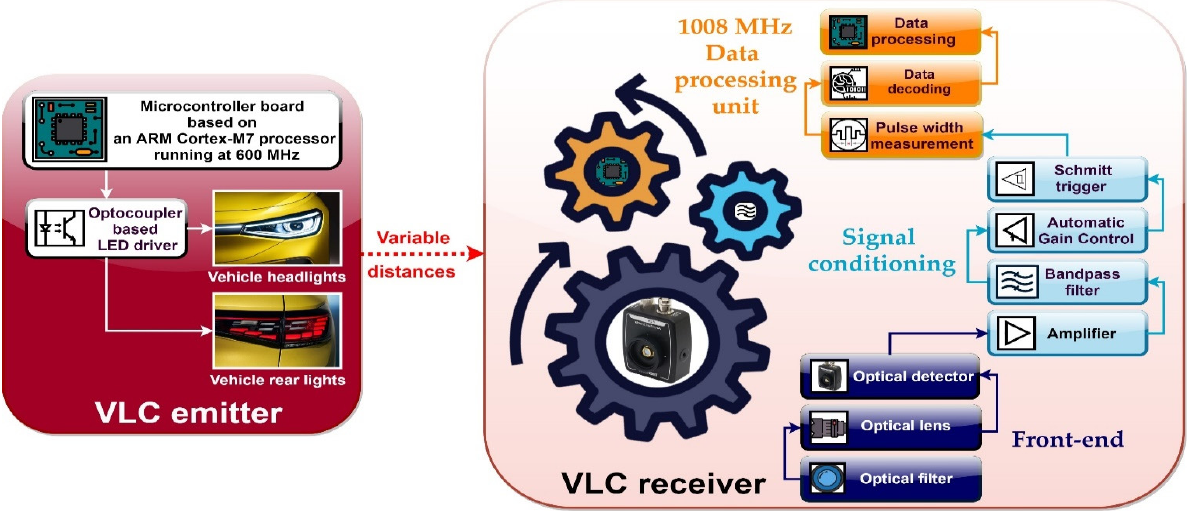
Sensors 2021 , 21 , x FOR PEER REVIEW Figure 4. Schematic representation of the VLC system. Figure 4. Schematic representation of the VLC system.